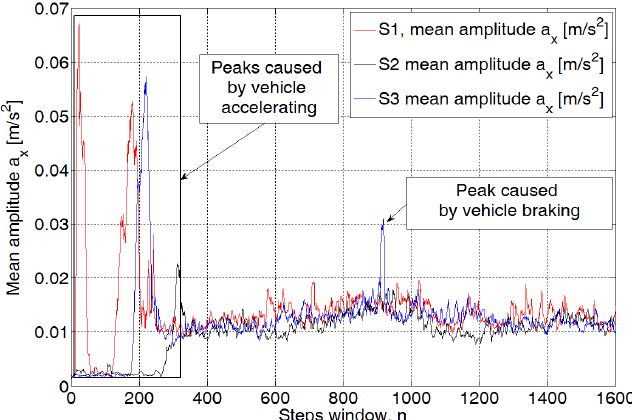
Figure 12. Average value of the passenger car body longitudinal acceleration signal during the test on road surface A.